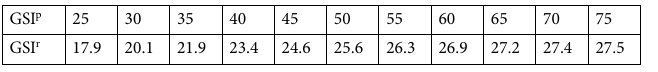
Table 1. GSI p and GSI r